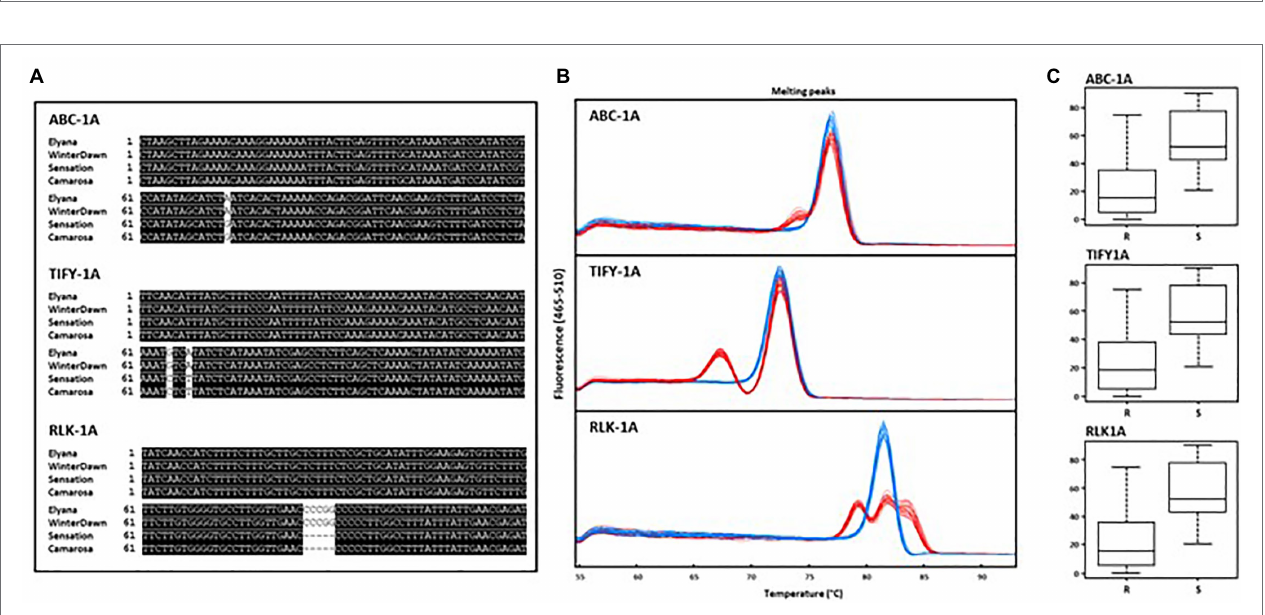
FIGURE 6 | Physical map of the FaRCg1 locus with genes upregulated in response to C. gloeosporioides highlighted in green, and the newly designed sub- genome specific markers are represented in red.